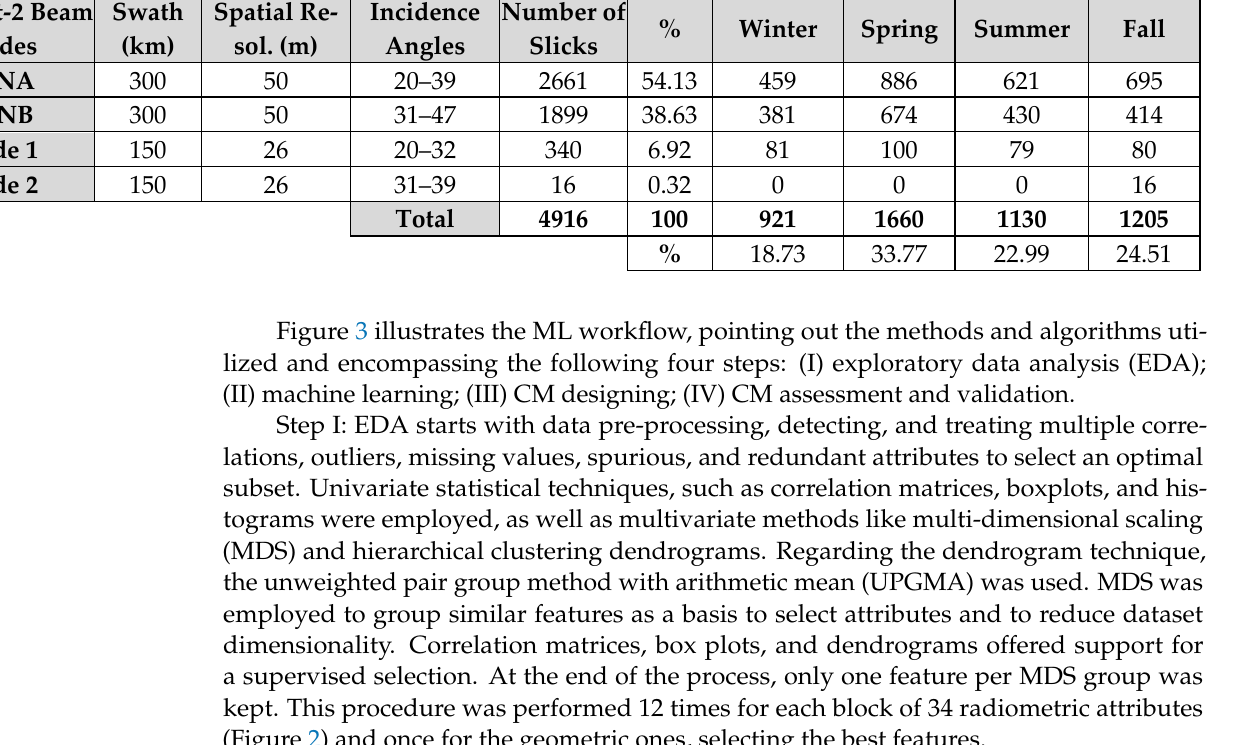
Table 1. RADARSAT-2 imaging modes and the number of oil slicks per beam and season. Radarsat-2